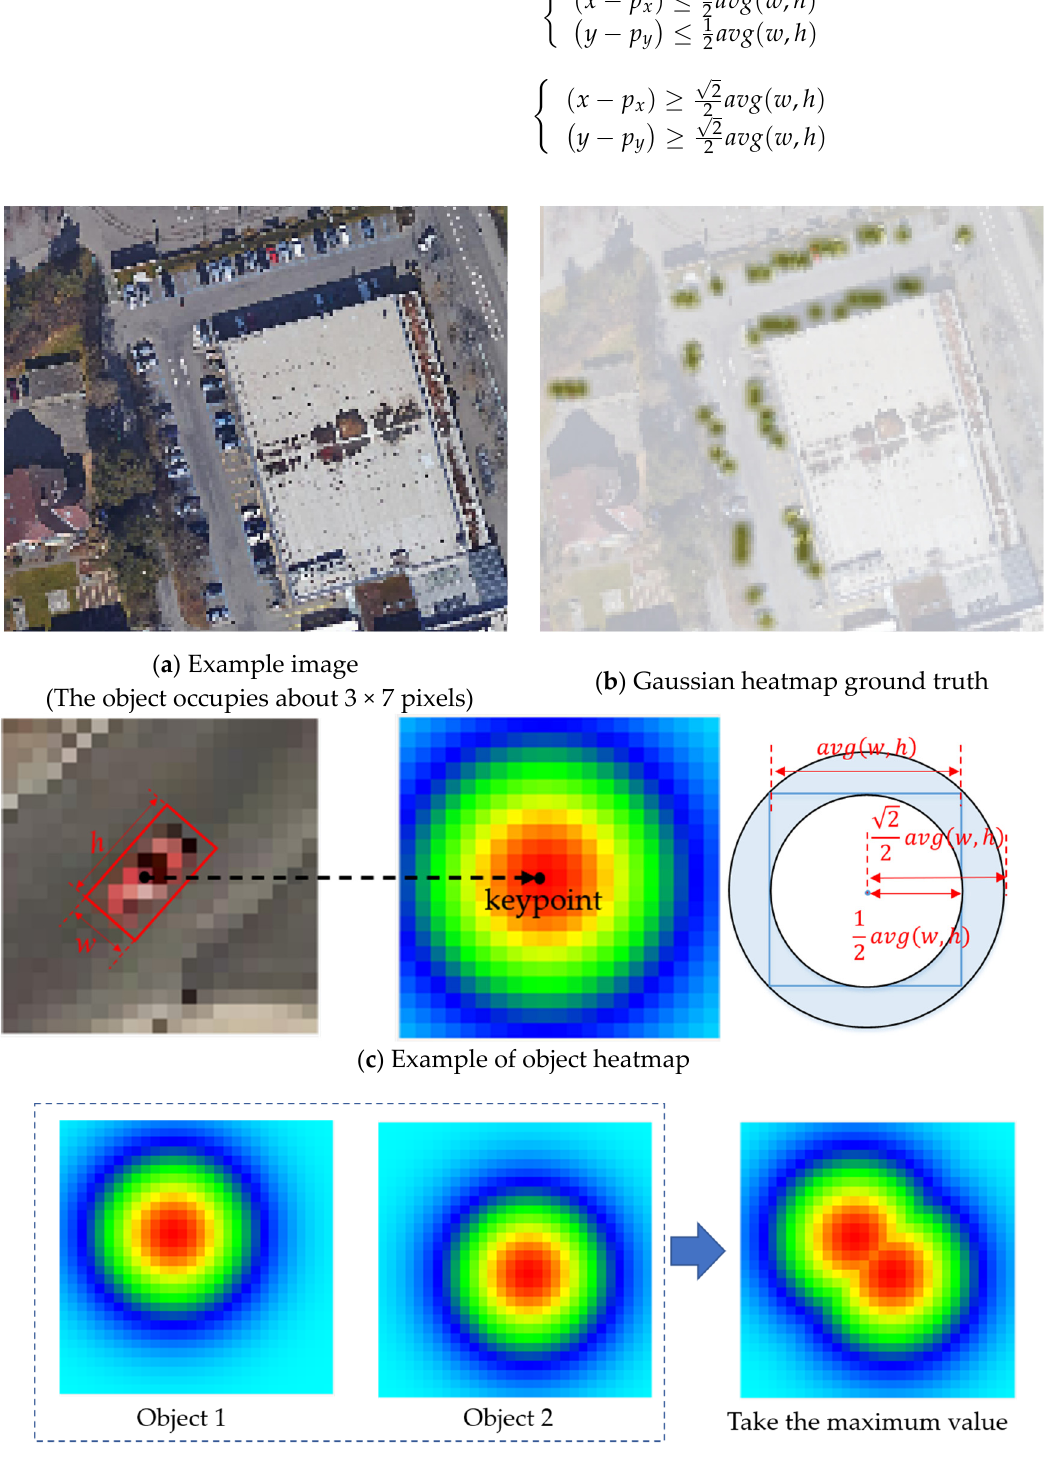
Figure 3. Gaussian heatmap. ( a ) An example image with some small-sized vehicles. ( b ) Gaussian heatmap ground truth of the image ( a ). ( c ) An example of object heatmap, and the threshold of the distance from the keypoint. ( d ) When the Gaussian functions belonging to the same class of objects overlap, the maximum value is taken.